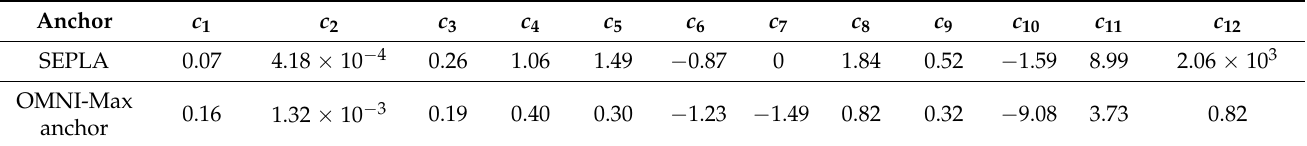
Table 2. Coefficients in Equation